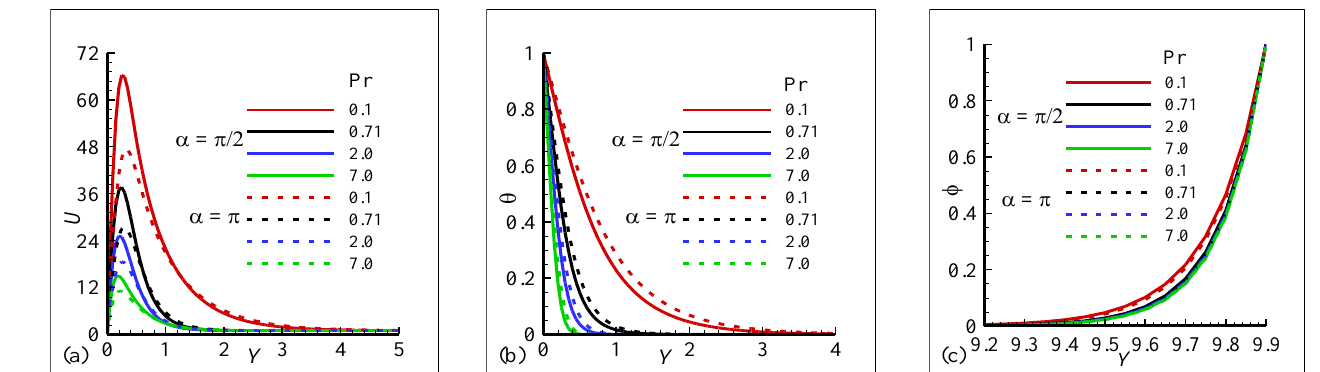
Figure 2. The geometrical representation of ( a ) 𝑈 , ( b ) 𝜃 and ( c ) 𝜙 at 𝜋 2⁄ and 𝜋 positions with four choice values of reduced gravity Rg = 0.1, 0.3,0.5 and 0.7 with some fixed parameters 𝜉 = 0.8 , 𝛾 = 0.5 , Pr = 7.0 , and 𝜆 = 1.5 .